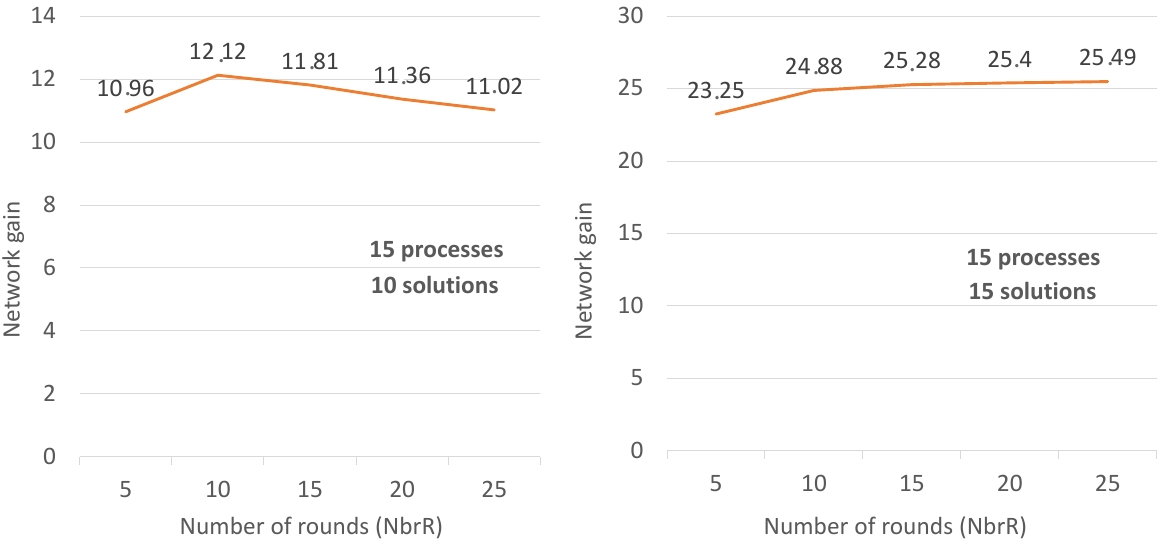
Figure 4. The influence of NbrR, case